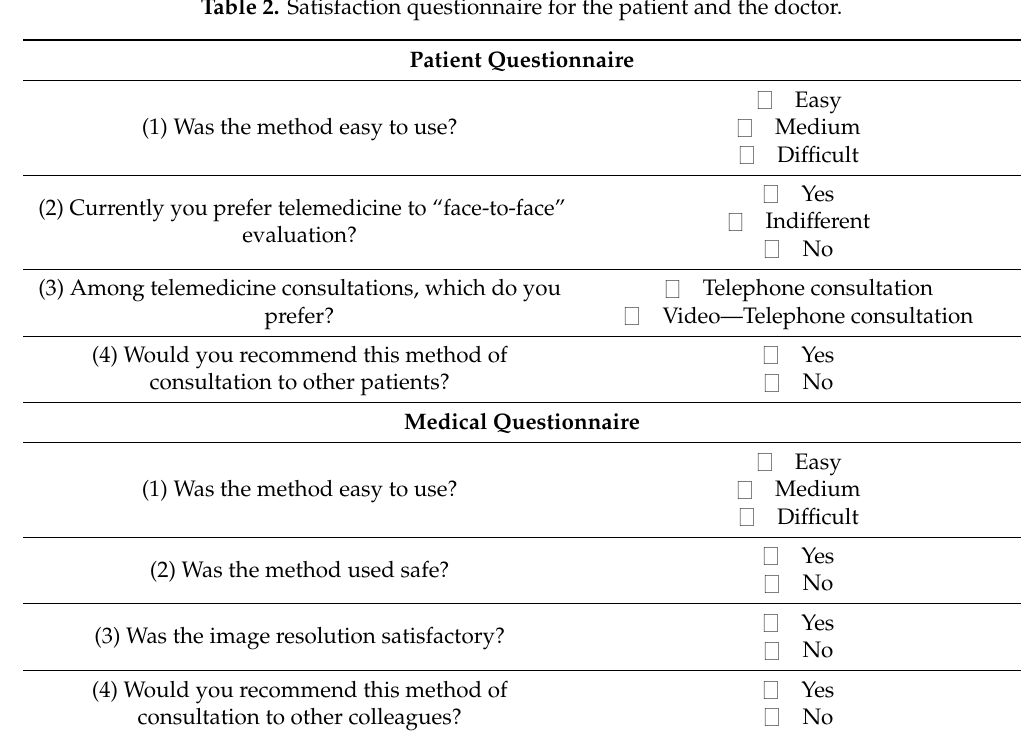
Table 2. Satisfaction questionnaire for the patient and the